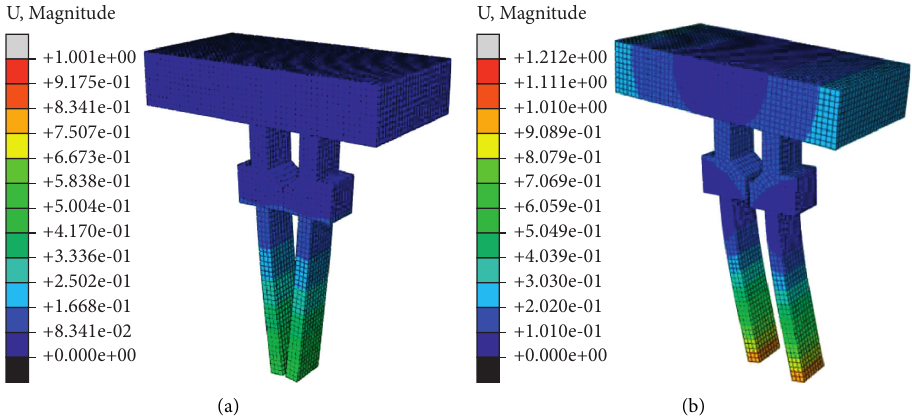
Figure 11: First and second vibration mode of experimental set-up-Finite element analysis. (a) First mode; (b) second